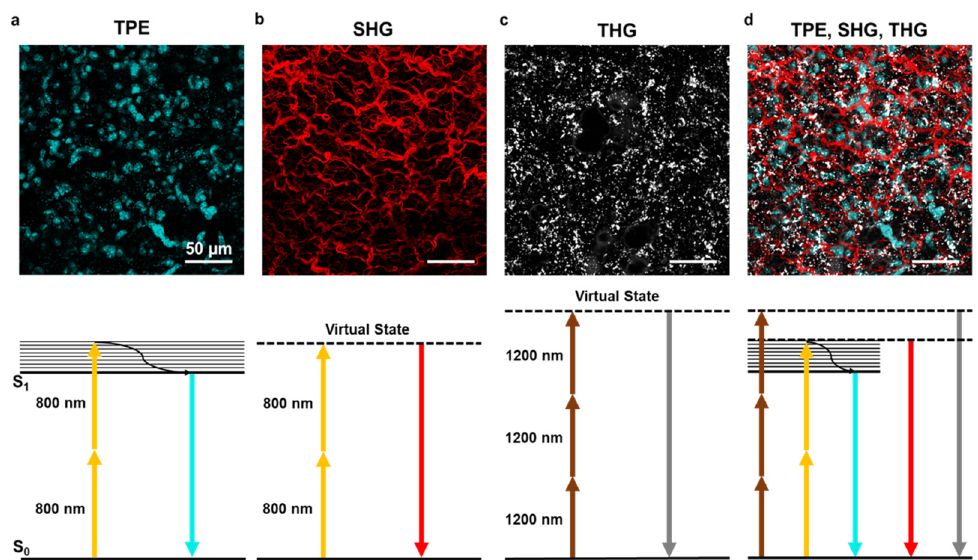
Figure 2. Two-photon excitation, second and third harmonic generation. ( a ) Example of two-photon excitation (TPE) of DAPI stained nuclei in lung tissue. Bottom panel shows the corresponding Jablonski diagram using 800 nm excitation wavelength. ( b ) Second harmonic generation (SHG) signal elicited with 800 nm wavelength on lung tissue collagen structure. The bottom panel shows the corresponding Jablonski diagram using 800 nm excitation wavelength. ( c ) Third harmonic generation (THG) signal of lipid bodies in lung tissue using 1200 nm wavelength. The bottom panel shows the corresponding Jablonski diagram. ( d ) A combination of TPE, SHG, and THG can be obtained using two laser sources at different wavelengths. Images obtained with the 800 nm source are merged with THG obtained with the 1200 nm source. The scale bar is 50 µm for all im- ages.